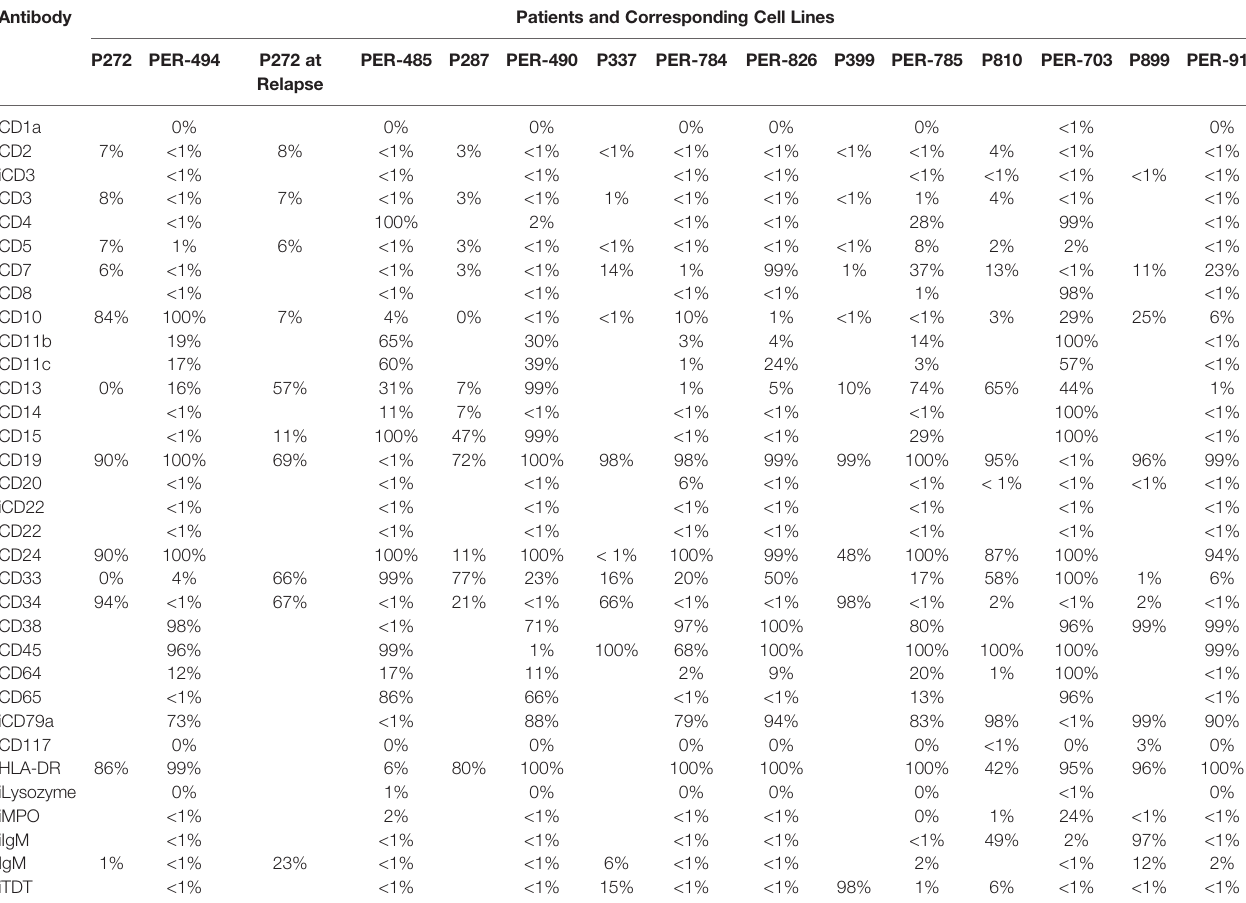
TABLE 2 | Immunophenotype of primary patient samples and corresponding cell lines. Antibody Patients and Corresponding Cell